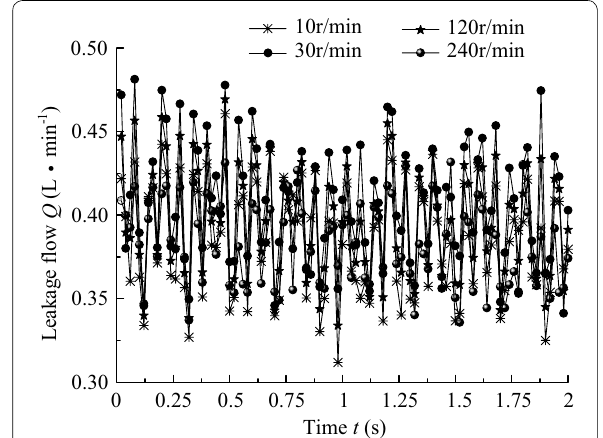
Figure 14 Leakage flow of port plate pairs at various rotating